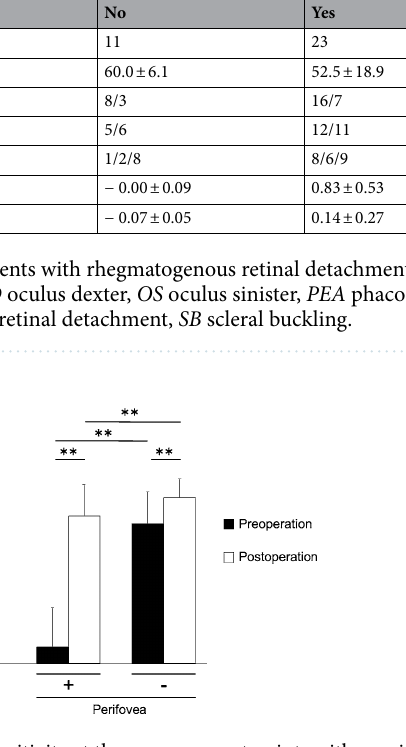
Figure 1. Changes in retinal sensitivity at the measurement points with or without preoperative retinal detachment in eyes with rhegmatogenous retinal detachment. At both the fovea and perifovea, the postoperative retinal sensitivity is significantly better than the preoperative retinal sensitivity, regardless of the presence of preoperative retinal detachment at the measurement points. The postoperative retinal sensitivity at the measurement points with preoperative retinal detachment is significantly worse than that at measurement points without preoperative retinal detachment. RD retinal detachment; * P < 0.01; ** P <